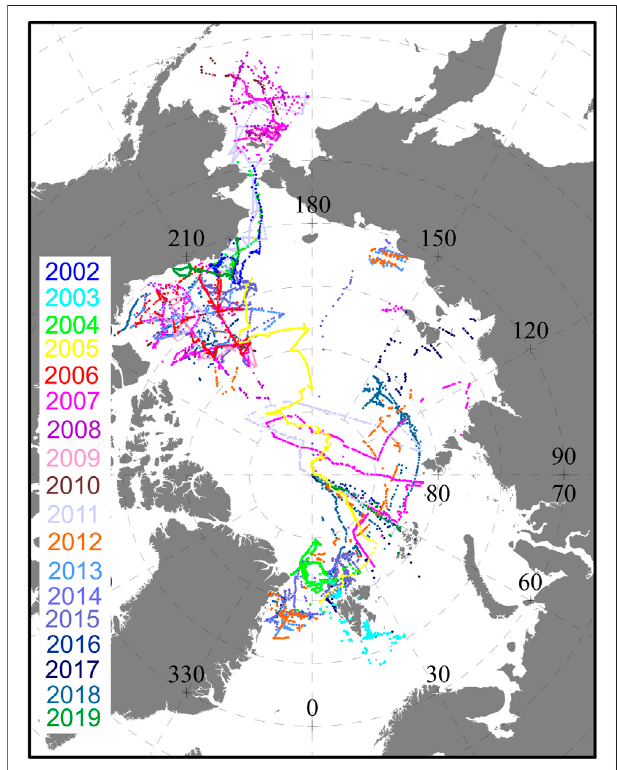
FIGURE 1 | Distribution of ship-based observation points in the Arctic